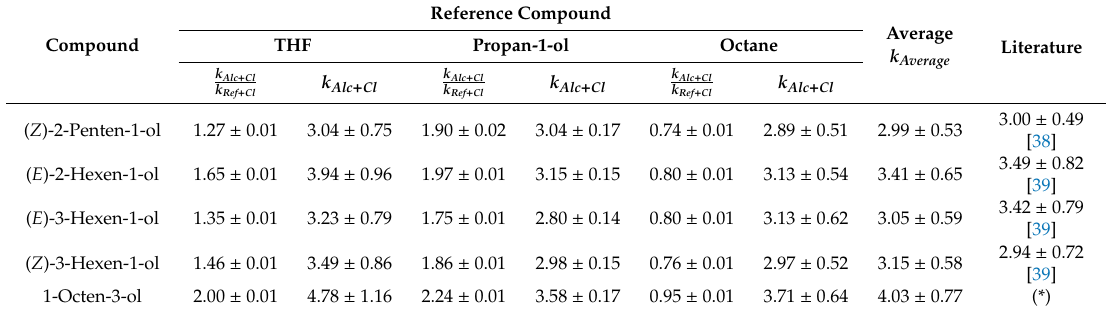
Table 1. Summary of all the rate constants for the reactions of alcohols with Cl atoms (all rate constants are expressed in 10 − 10 cm 3 · molecule − 1 · s − 1